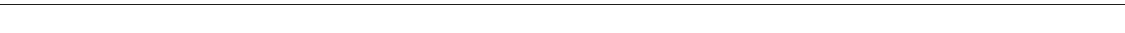
Fig. 5 TMEM106B drives nuclear translocation of TFEB and regulates TFEB-mediated expression of lysosomal genes. a 393P cells with inducible expression of TMEM106B or GFP alone were transfected with Mcherry-TFEB construct. After induction for 24 – 48 h, cells were counter stained with Hoechst33342. Live cells were imaged in real time. Indicated scale bar = 5 µ m. b Western blot analysis upon subcellular fractionation of cells with induction of GFP- TMEM106B or GFP alone as control. c , d qPCR analysis for expression of lysosomal genes upon expression or knockdown of TMEM106B expression. e Heatmap of intergene expression correlation across 1016 lung cancers from TCGA 49 . Color bar represents Pearson ’ s r value (based on log-transformed values); red is positive correlation. f Western blot analysis after transfection of either control siRNA or siRNA against TFEB in cells expressing either GFP alone or GFP-TMEM106B. g qPCR analysis for expression of lysosomal genes upon induction of GFP alone as control (Vec) or TMEM106B expression, after transfection of either control siRNA or siRNA against TFEB in cells expressing either GFP or GFP-TMEM106B. h Relative cathepsin B or cathepsin K activity as measured by quanti fi cation of fl uorescence intensity after staining with Magic Red Cathepsin B or K reagent to assess for activity of cathepsin B or K, in cells as described in g . All asterisks indicate statistical signi fi cance by t test ( n ≥ 3, * p ≤